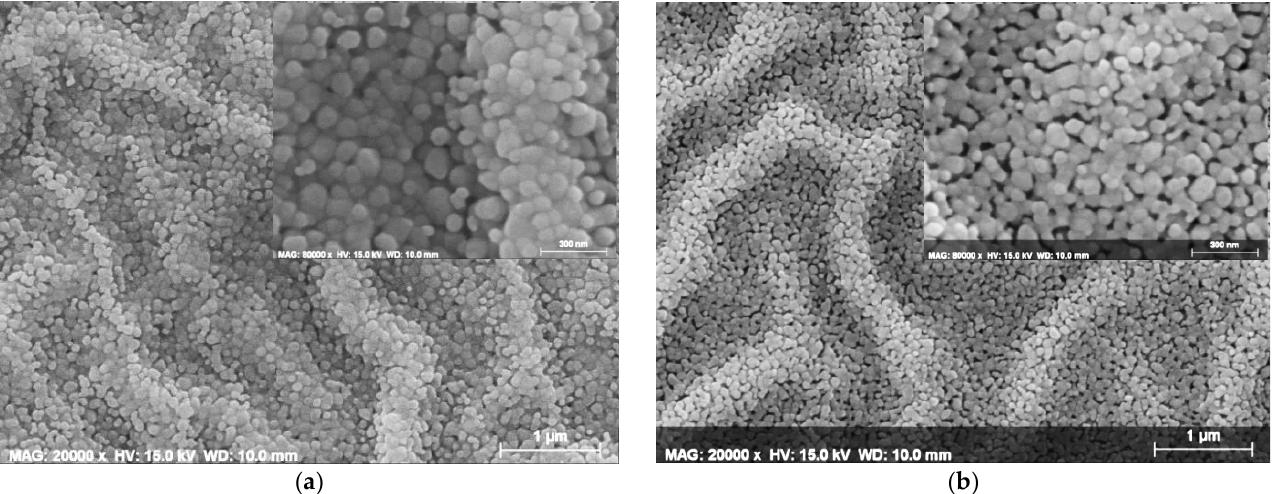
Figure 15. FESEM micrographs of ZnO films, deposited at a spin coating speed of ( a ) 2000 and ( b ) 4000 rpm and treated at 600 °C. The magnification is 20,000. The inset images present the film surfaces at a greater magnification of 80,000.